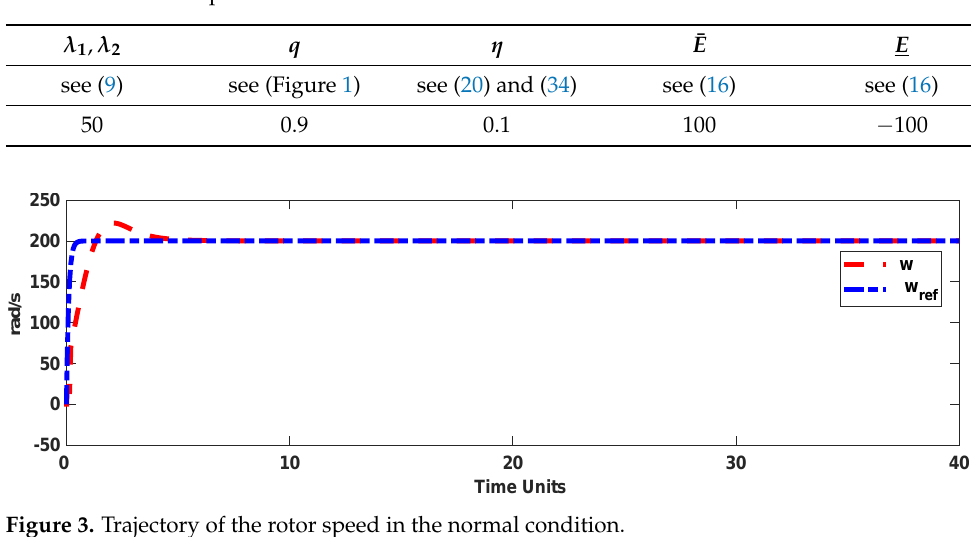
Table 2. The control parameters.